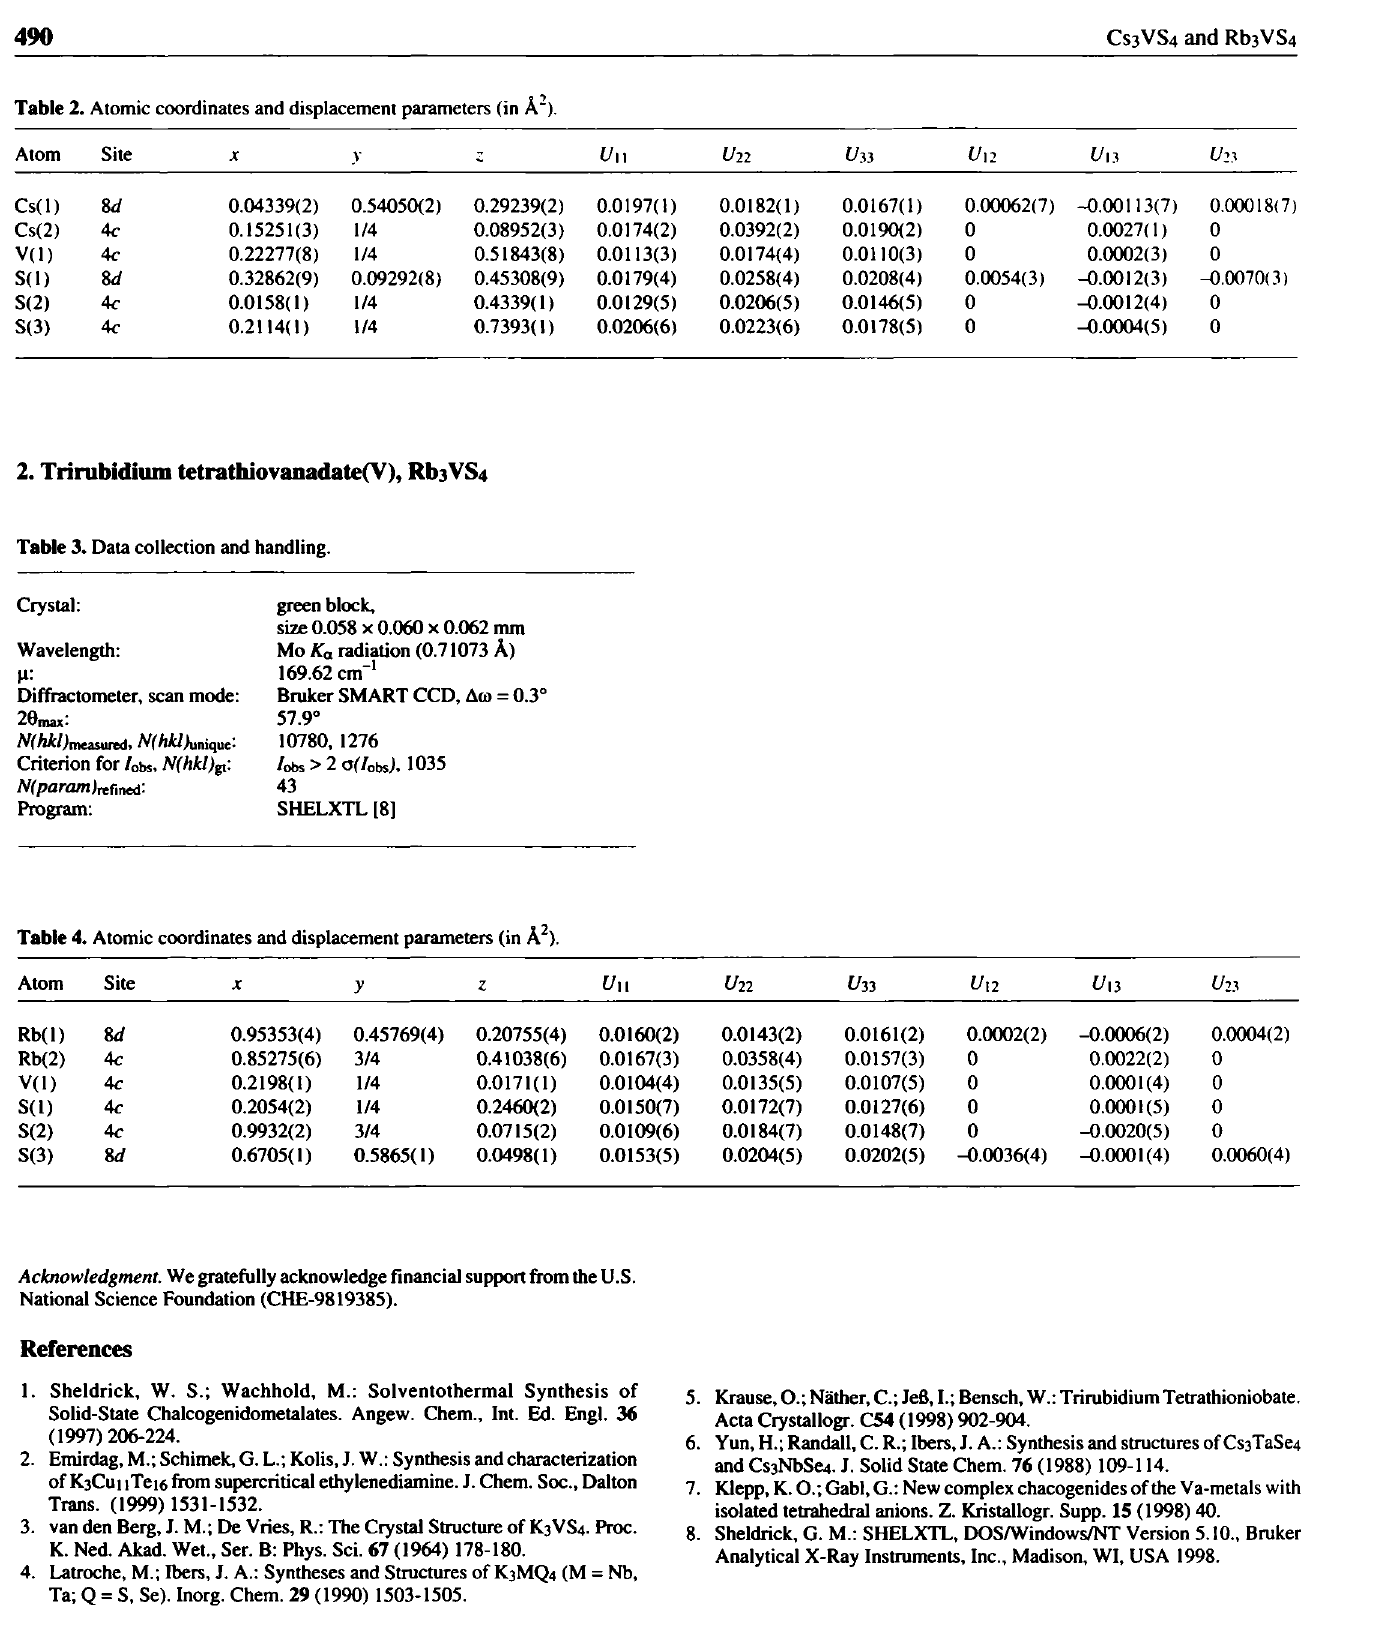
Table 2. Atomic coordinates and displacement parameters (in Ä 2 ).